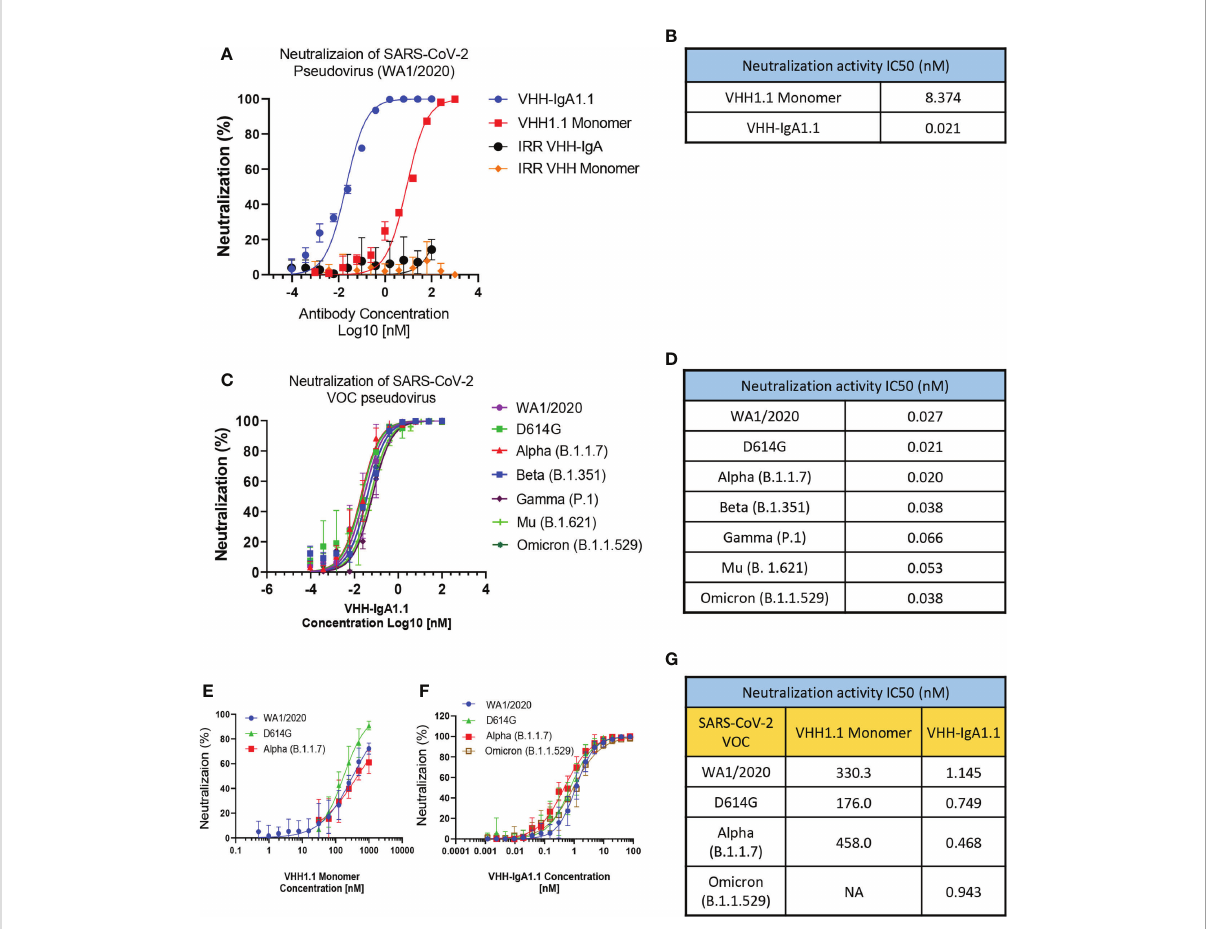
FIGURE 2 VHH-IgA1.1 potently neutralizes SARS-CoV-2 VOC. Monomeric VHH1.1 and VHH-IgA1.1 mediated in vitro neutralization of luciferase-encoding pseudovirions with full length spike proteins presented in SARS-CoV-2 (A) and indicated VOC (C) . Pseudoviral transduction was measured by luciferase activities to calculate neutralization (%) relative to non-antibody-treated controls. Dose-Response Curve generated from PRNT of monomeric VHH1.1 (E) and VHH-IgA1.1 (F) against indicated authentic virus of SARS-CoV-2 VOC on Vero E6 cells. (B, D , G) Data was plotted as the average ± SD, and IC 50 values were calculated by nonlinear regression analysis. Three or more independent biological replicates were completed for each antibody. NA=not